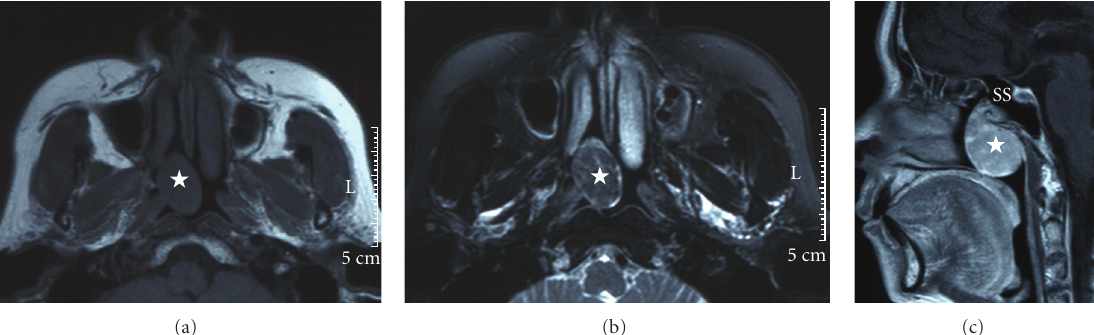
Figure 2: T1- (a) and T2-weighted (b) magnetic resonance (MR) images of the tumor ( (cid:2) ). Gd-enhanced sagittal MR image (c) revealed that the tumor originated in the right sphenoid sinus (SS).